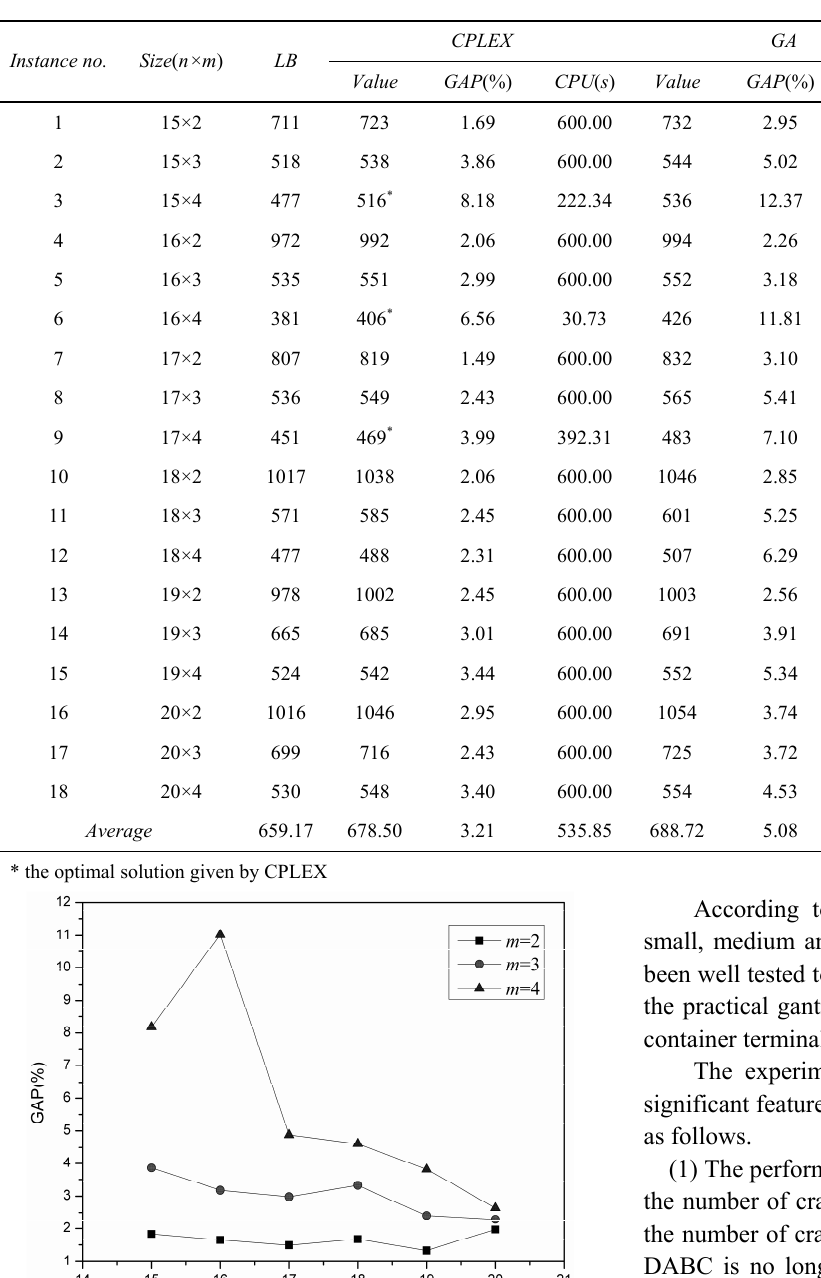
Table 4. Results of random instances with medium sizes